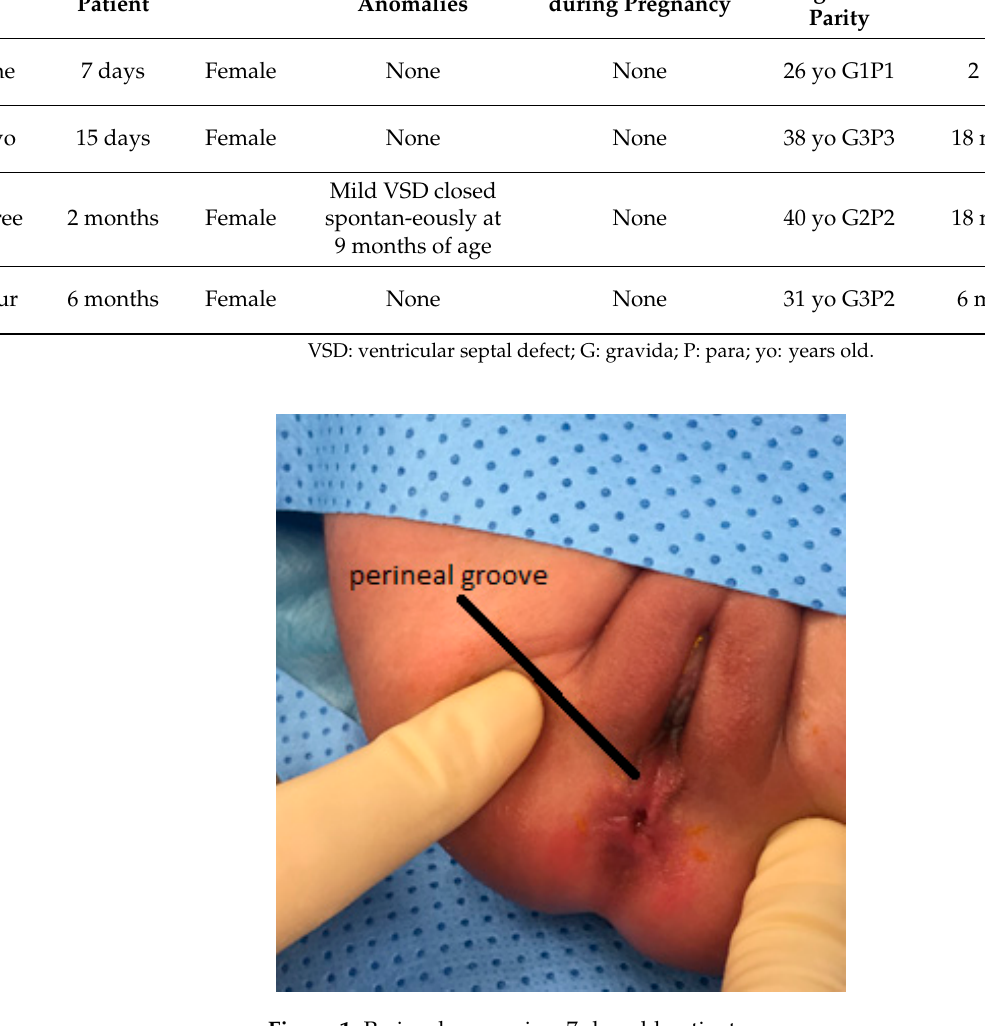
Table 1. Demographic data of 4 cases.